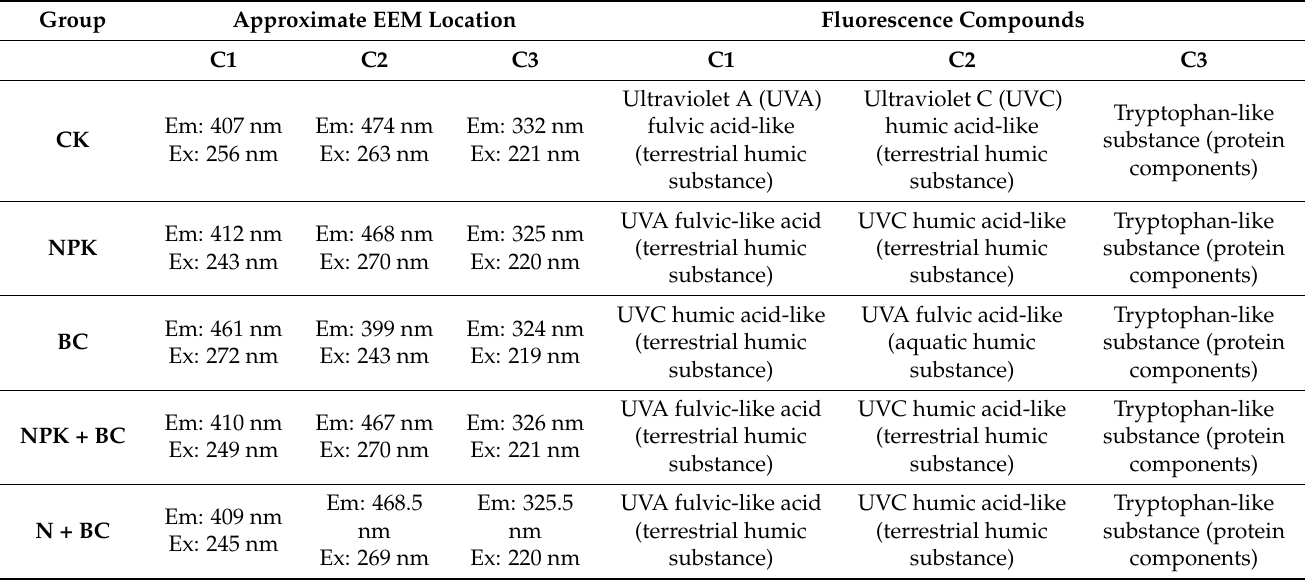
Figure 2. EEMs of the five treatment groups: ( a ) CK; ( b ) NPK; ( c ) BC; ( d ) NPK + BC; and ( e ) N + BC. Table 4. EEM locations and the three fluorescence components determined by PARAFAC modeling in the five treatment